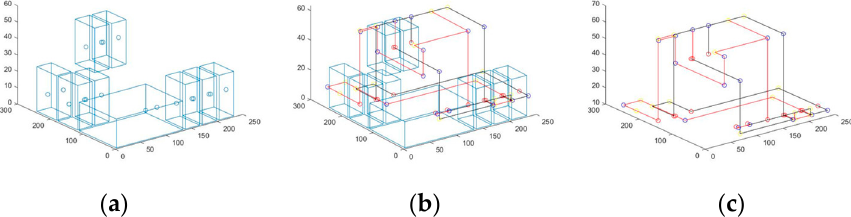
Figure 8. ( a ) The randomly generated layouts; ( b ) the routing results of our routing algorithm; ( c ) the final result of the bus connection.